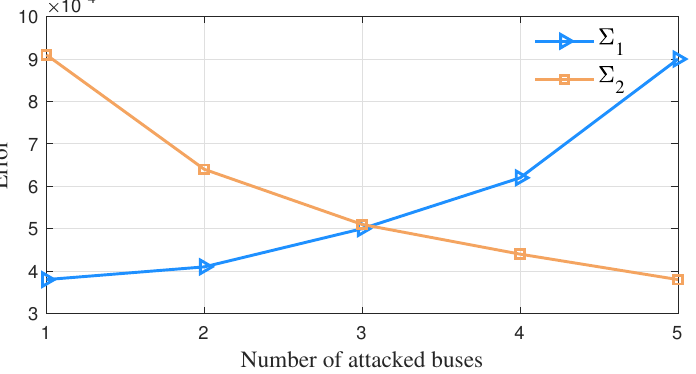
Figure 10. The error variation of the parameter Σ while the number of attacked buses varies. As the proportion of false data in the overall data increases, the probabilities of false data detection, missed detection and false detection by this algorithm change, as shown in Figure 11. It can be seen that the detection rate of the algorithm for false data is basically above 95%, and the detection probability can be further improved to above 99% as the amount of false data increases; thus, the probabilities of false detection and missed detection are normally below